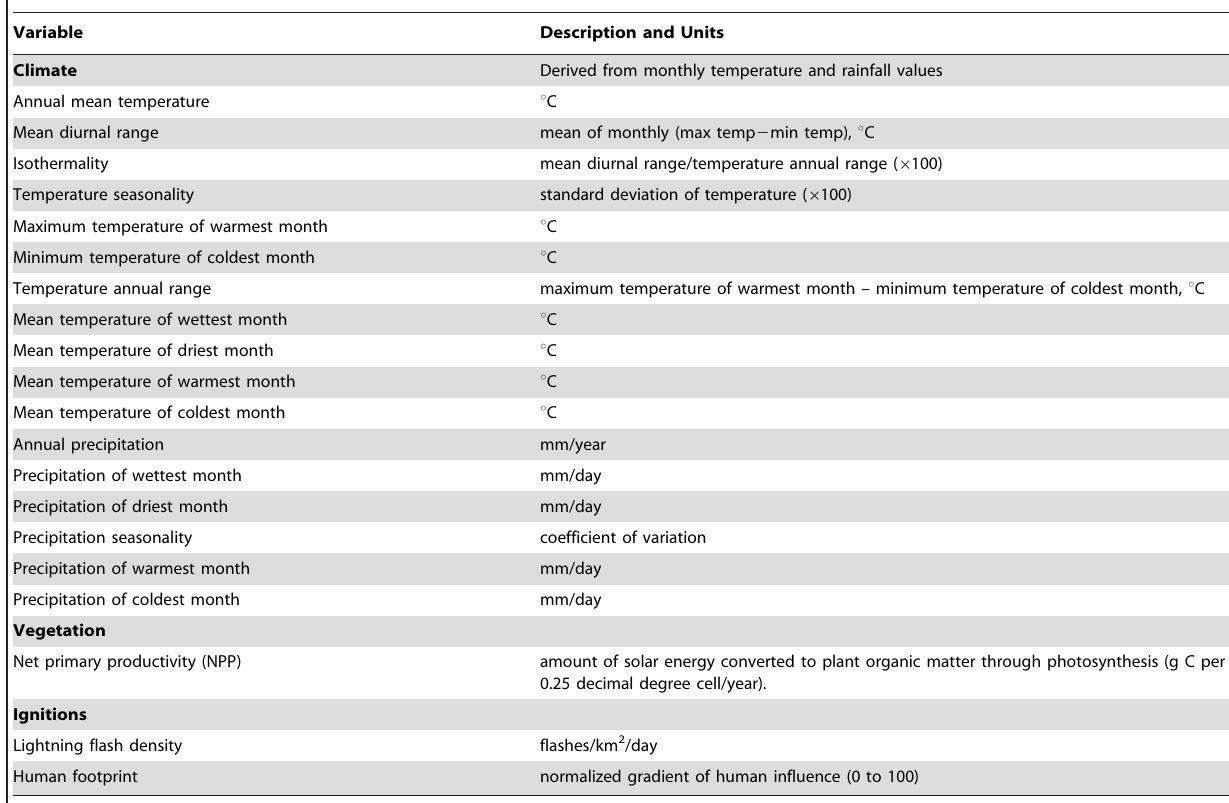
Table 1. Environmental variables used in regression